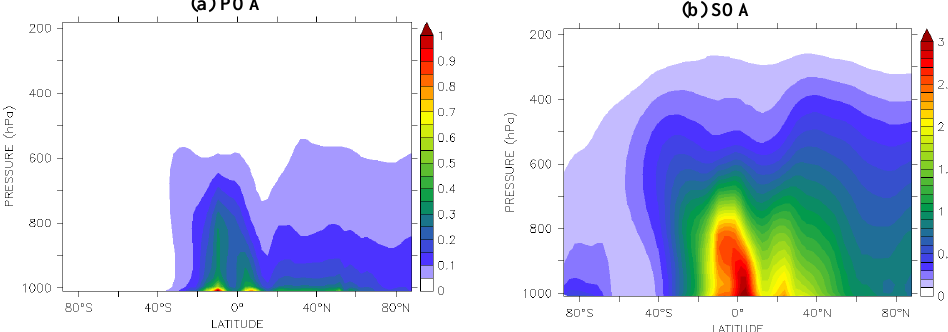
Figure 9. Modeled average zonal concentrations (in µgm − 3 ) of (a) POA (sum of fPOA and bbPOA) and (b) SOA (sum of fSOA-sv, bbSOA- Figure 9: Modeled average zonal concentrations (in μg m -3 ) of (a) POA (sum of fPOA and 1281 bbPOA) and (b) SOA (sum of fSOA-sv, bbSOA-sv, fSOA-iv, bbSOA-iv, aSOA-v, and bSOA-v) 1282 sv, fSOA-iv, bbSOA-iv, aSOA-v, and bSOA-v) during the years